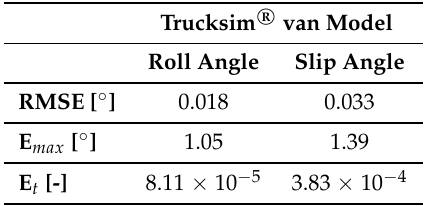
Table 2. Error measurements for the training and test